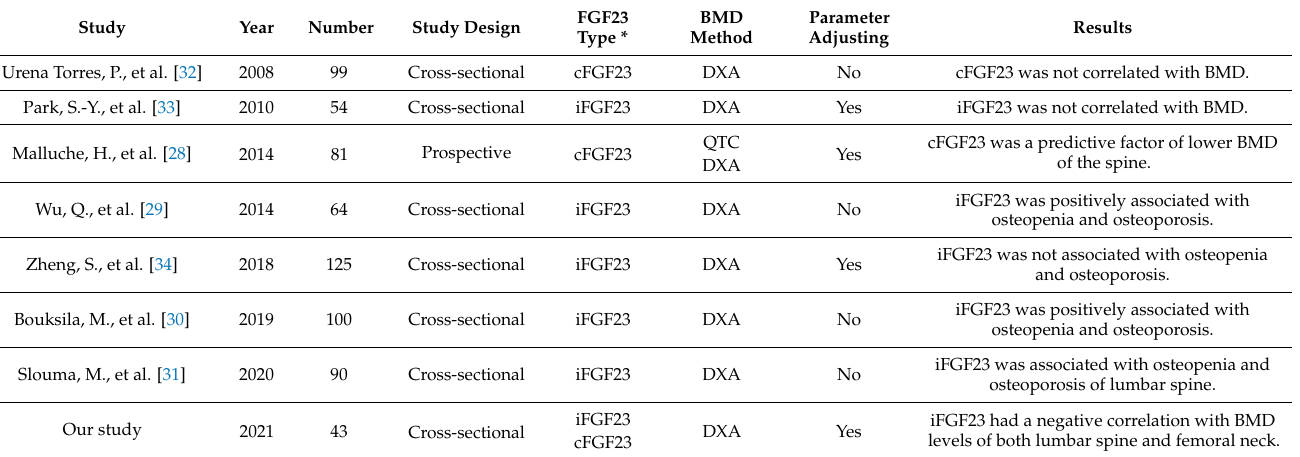
Table 4. Literature review of the association between serum FGF23 levels and BMD in chronic hemodialysis